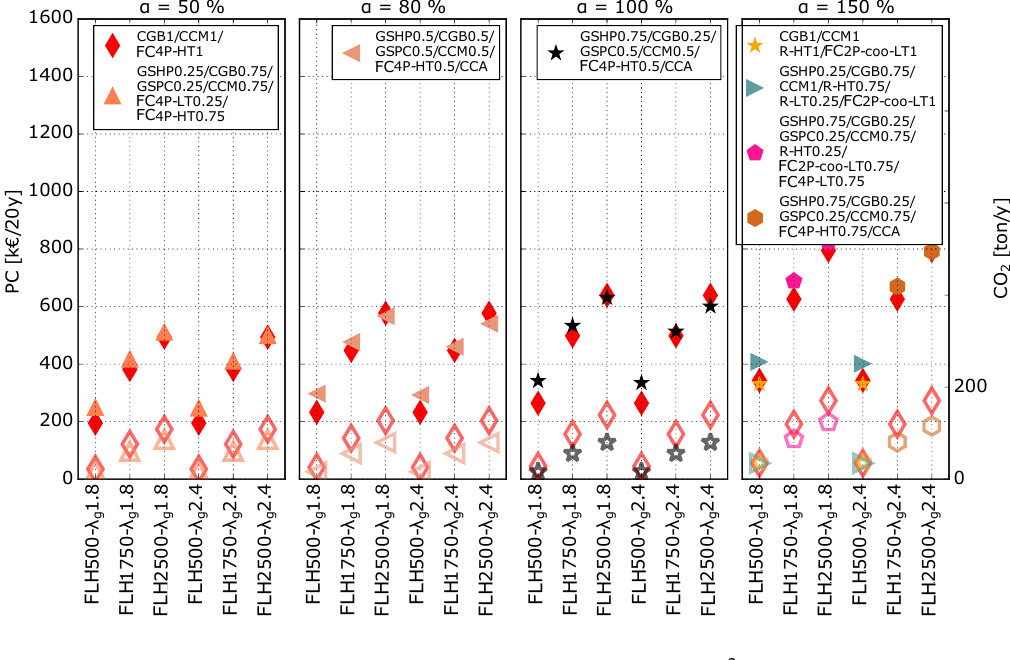
Figure 8. Same as Figure 7 but P spe = 70 W/m 2 .